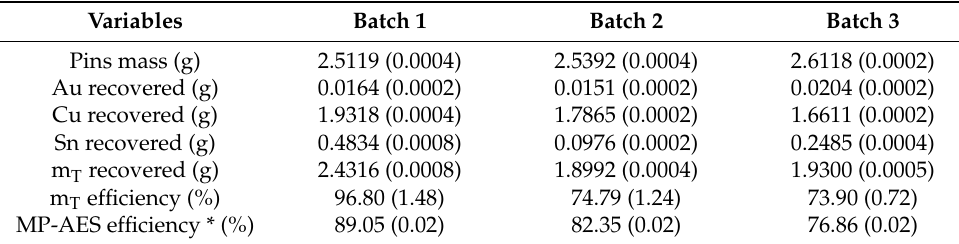
Table 3. Mass and MP-AES efficiencies of the products obtained in batches 1, 2 and 3.